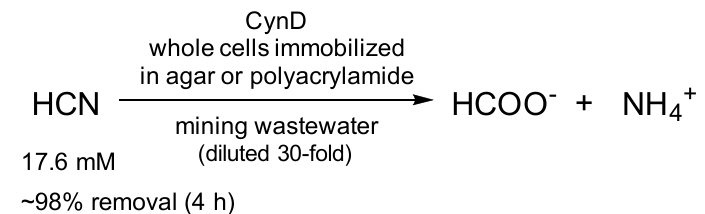
F. indicum [63] (Figure 9).